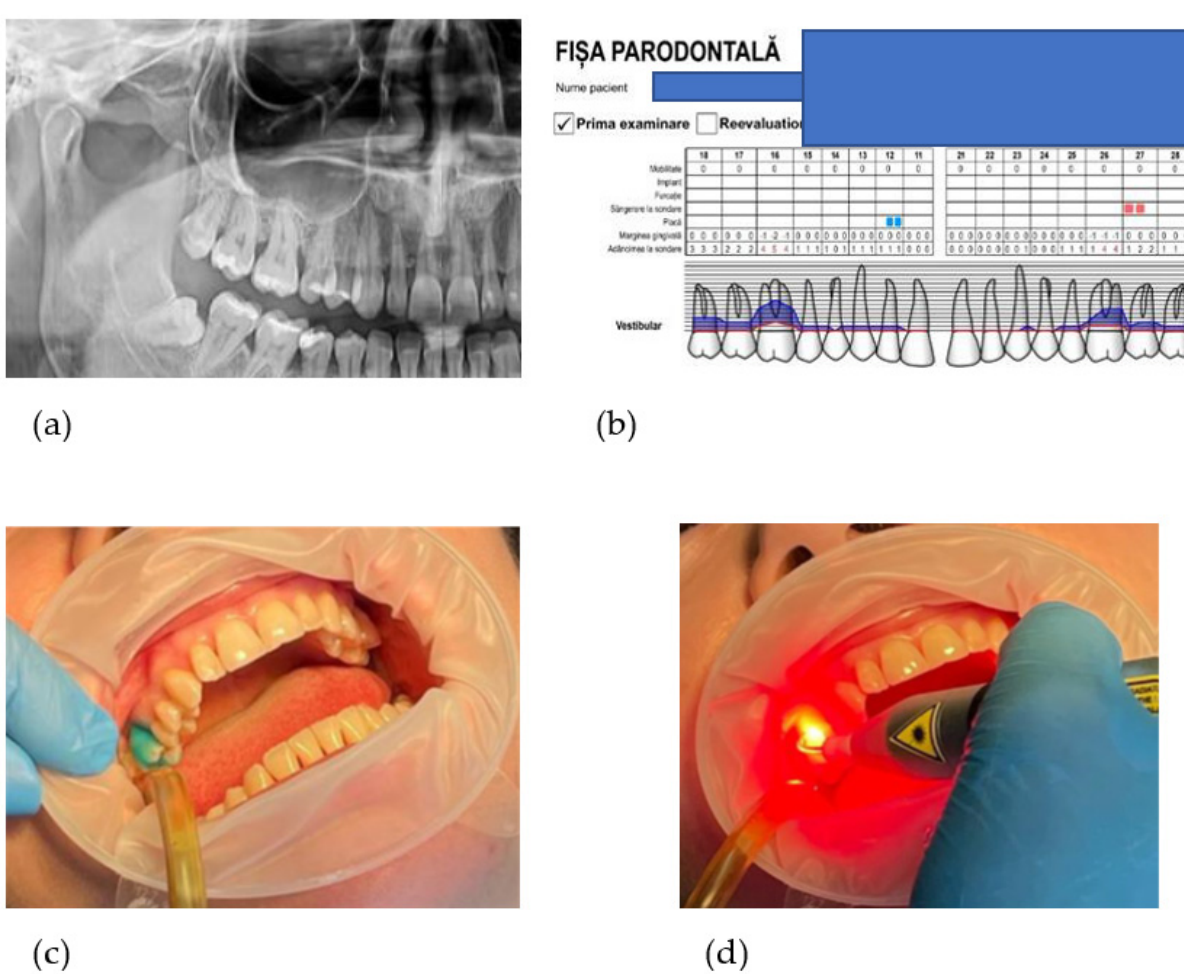
Figure 2. ( a ) patient X-ray showing the specific vertical bone loss in tooth 1.6; ( b ) periodontal chart showing the PD of the two selected sites for the study; ( c ) applying the photosensitizer dye liquid (Toluidine Blue Gel 0.005%; ( d ) photoactivation with the laser light at a wavelength optimized for toluidine blue solution (635 nm).